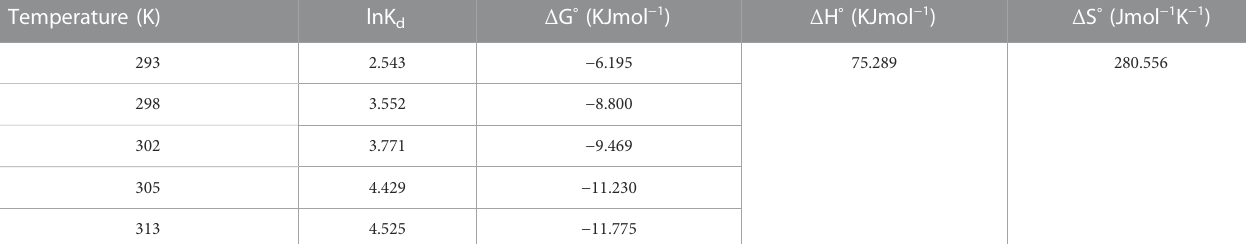
TABLE 3 Thermodynamic parameters for dye adsorption onto CM- β CD:nChi:Glu. Temperature